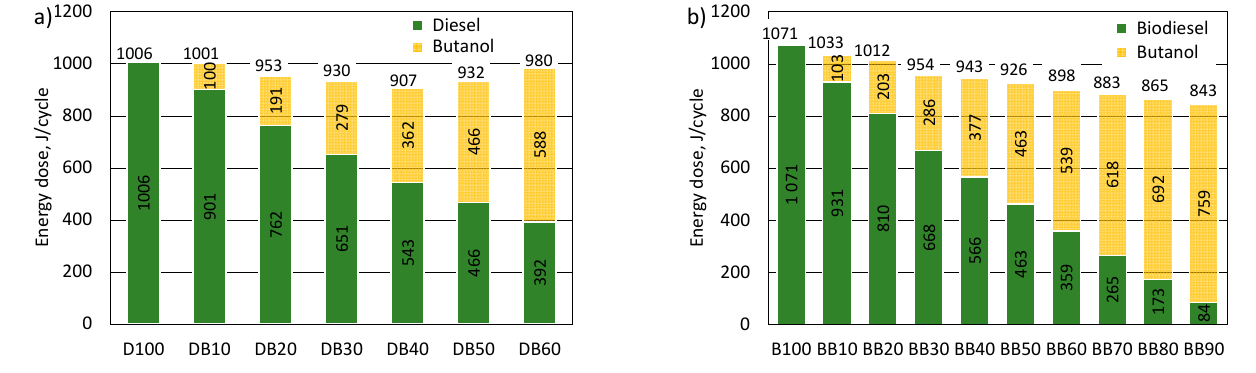
Figure 4. The effect of the addition of n-butanol to diesel ( a ) and RME biodiesel ( b ) on the energy dose of fuel delivered in each engine cycle.